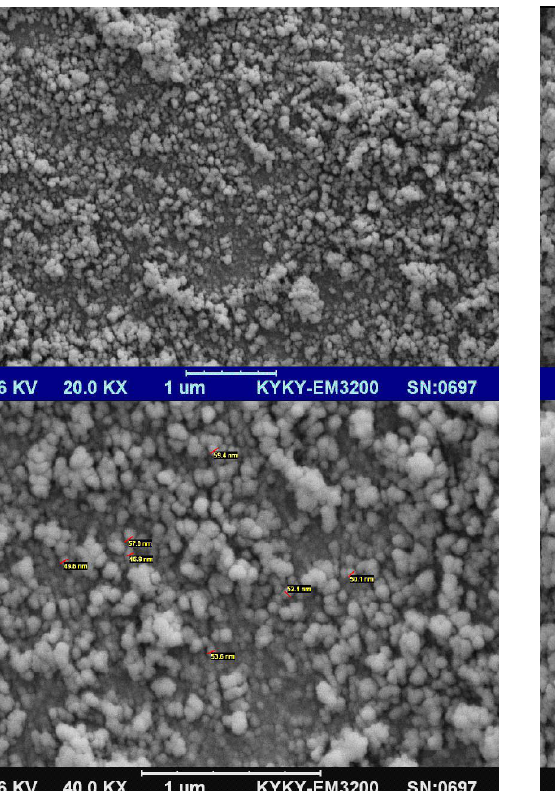
O nanoparticles 2 3